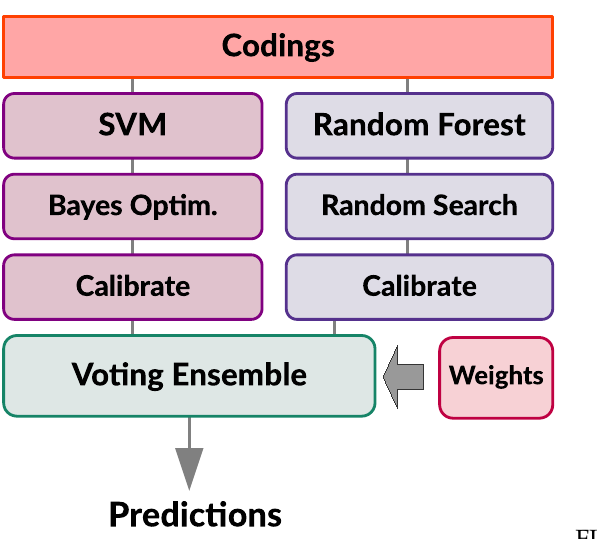
Figure 8. An overview of the voting ensemble classifier built from SVM and RF base models. Each base classifier is individually trained on the codings (training set) obtained from the autoencoder (Section 3.1) and produces independent predictions on the test set (i.e., outputs prediction probabilities, p ). Since the dataset is imbalanced, each base classifiers uses class weight balancing during training, in order to put more weight on the samples from the under-represented class (by automatically adjusting weights inversely proportional to the class frequencies in the input data) [52]. Base classifiers are trained using the f 1 –measure as a scoring metric and individually calibrated on the training set (Section